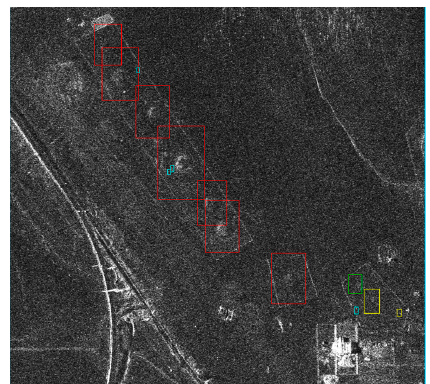
Figure 3. Cluster of Saka kurgans in the TSX ST image from 16 September 2015 (SAR image © DLR, 2015). ( Saka kurgans = red, Scythian kurgans = green, ogradkas = purple, undatable mounds = yellow, and all other objects = cyan).